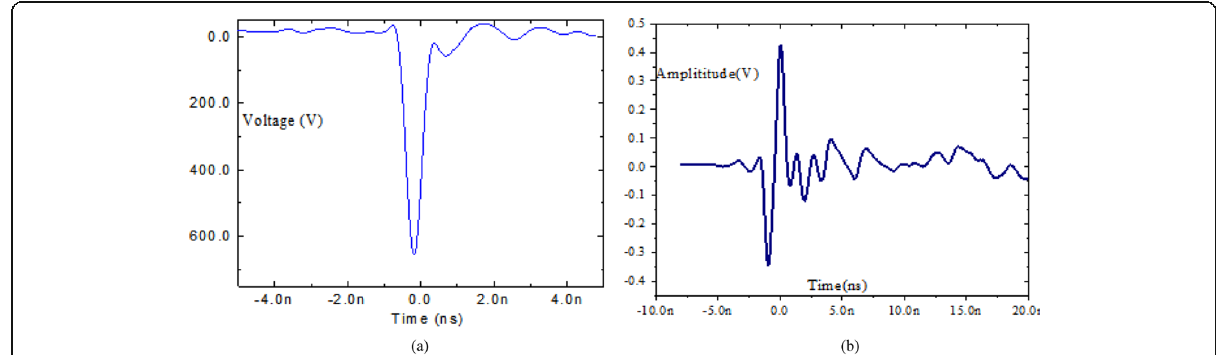
Fig. 8 Feed pulse waveform and the typical signal waveform received by receiving antenna. a Feed pulse waveform of pulse signal source. b Typical pulse signal waveform received by receiving antenna